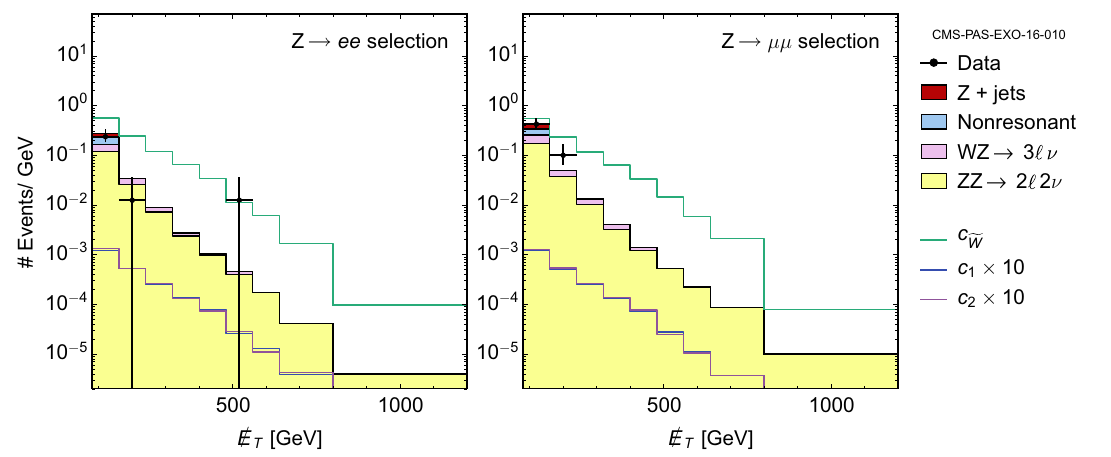
Fig. 5 / E T distribution for a Z ( Z → (cid:17) + (cid:17) − ) production in the ee + / E T final state ( left ) and μμ + / E T final state ( right ), generated from A ˜ ( green ), A 1 ( blue ), and A 2 ( purple ). Also shown are the binned exper-